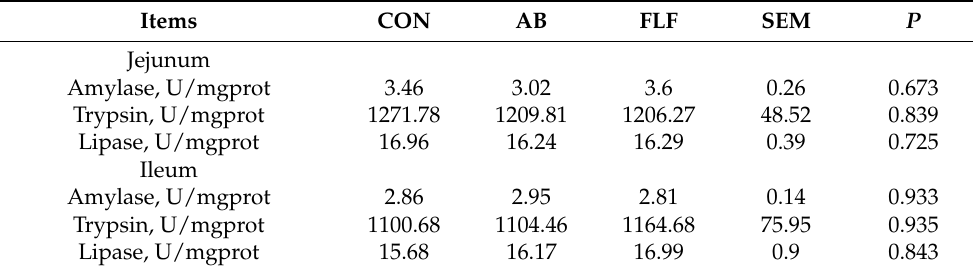
Table 6. Effects of fermented liquid feeding on digestive enzyme activities in the intestinal tissue of